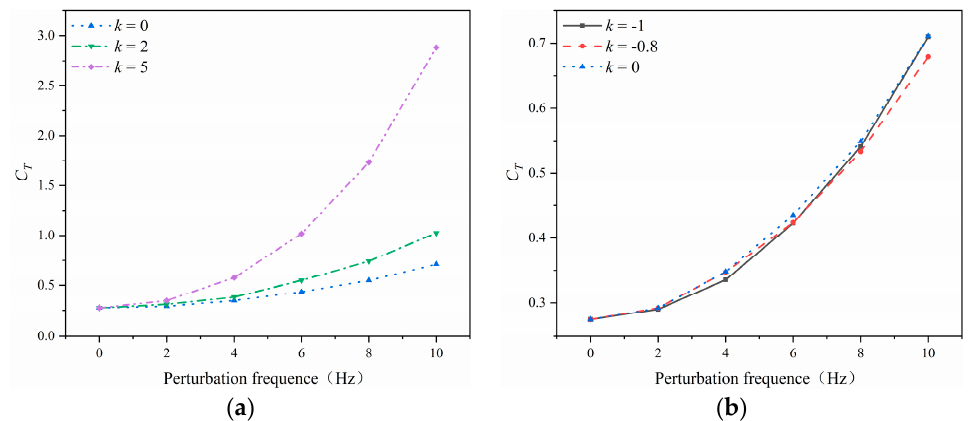
Figure 4. Variation of thrust coefficient: ( a ) a square wave vs. a sine wave and ( b ) a sawtooth wave vs. a sine wave.